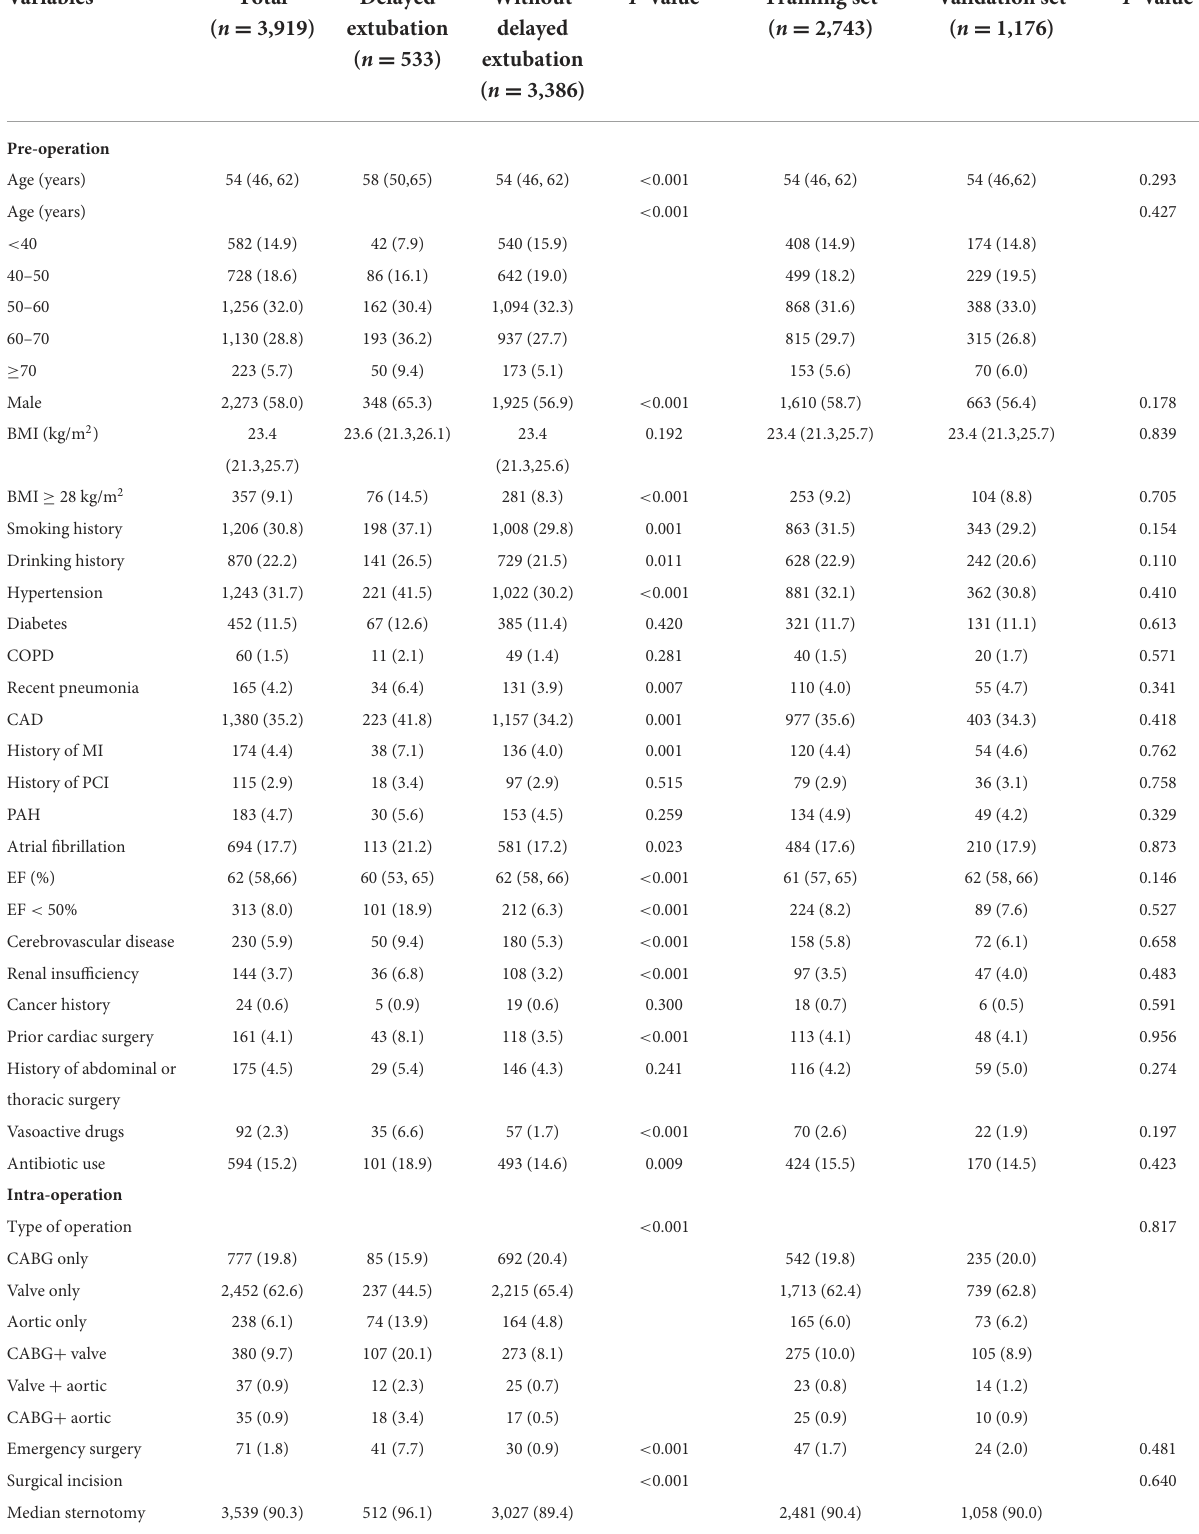
TABLE 1 The demographic and clinical characteristics of patients in the training and validation